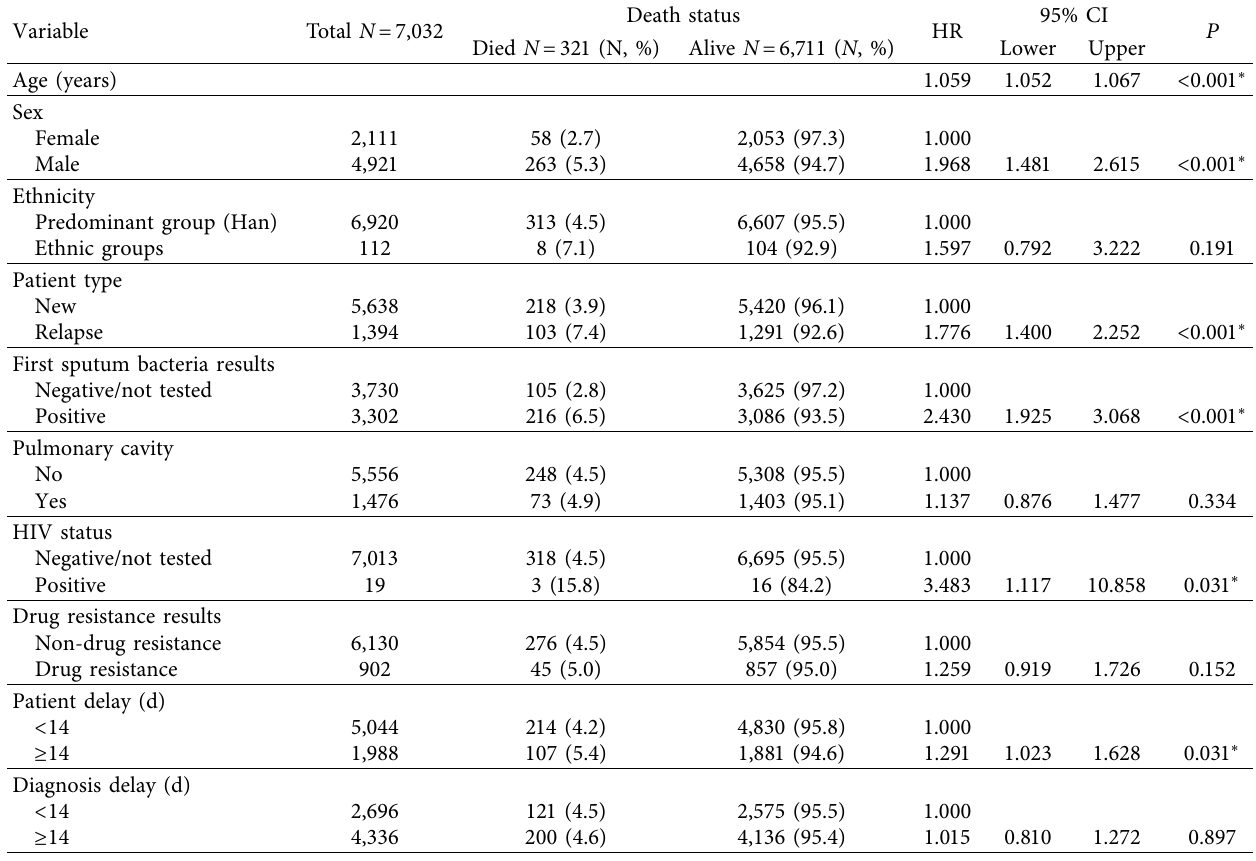
Table 2: Univariate analysis of risk factors for death during the treatment period in 7,032 tuberculosis patients.